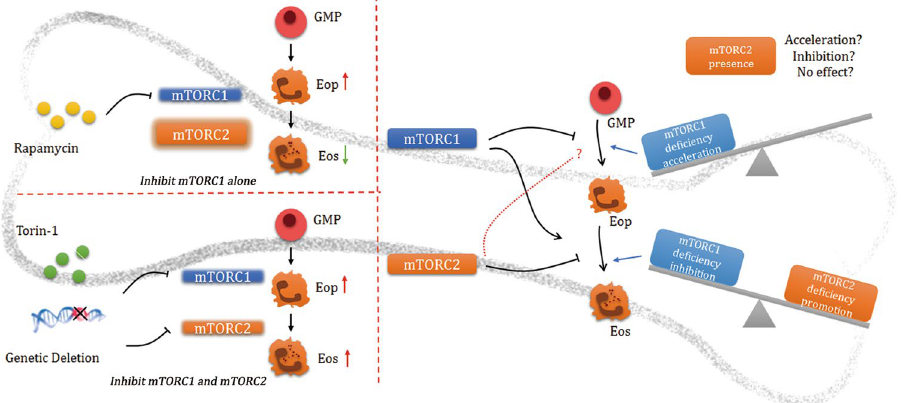
Figure 8. Summary. Administration of rapamycin results in increased Eop and diminished eosinophils by partially inhibits mTORC1, whereas torin-1 and genetic depletion of mTOR promotes both Eop and eosinophil development. We assumed that mTORC1 deficiency promotes Eop development, regardless of the effect mTORC2 exerts on Eop production from GMP. However, a loss of both mTORC1 and mTORC2 eventually increases the mature eosinophil, suggesting that mTORC2 plays a predominant role in suppressing eosinophil differentiation for Eop, regardless of, or overcoming the promoting effect of mTORC1 from Eop to mature